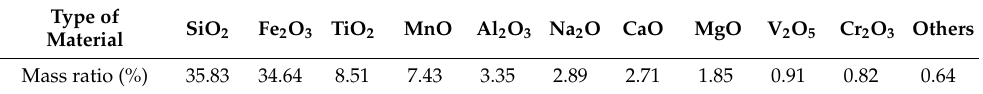
Table 7. Composition and proportion of MIRP.